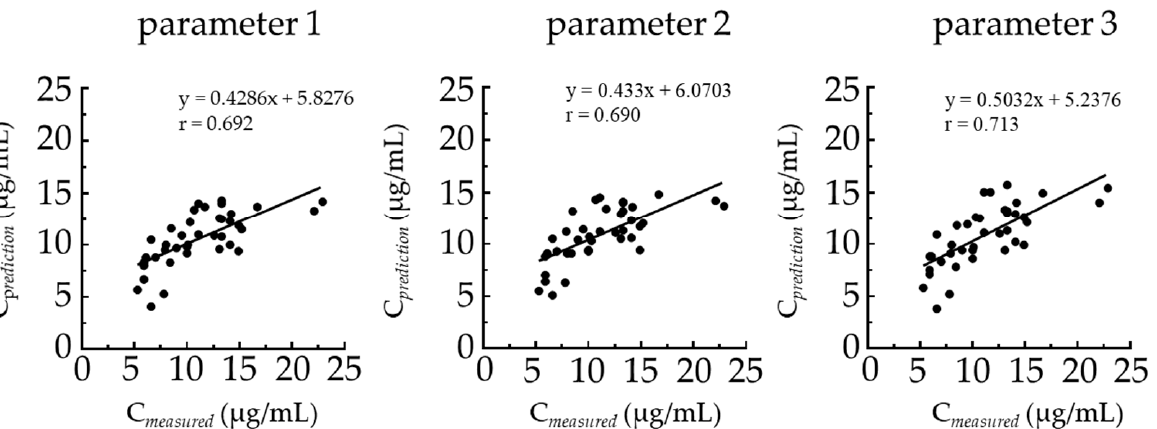
Figure 2. Correlation between the measured and predicted TEIC blood concentrations. Abbrevia- tions: C measured , measured TEIC blood concentration; C predicted , predicted TEIC blood concentration; TEIC, teicoplanin.